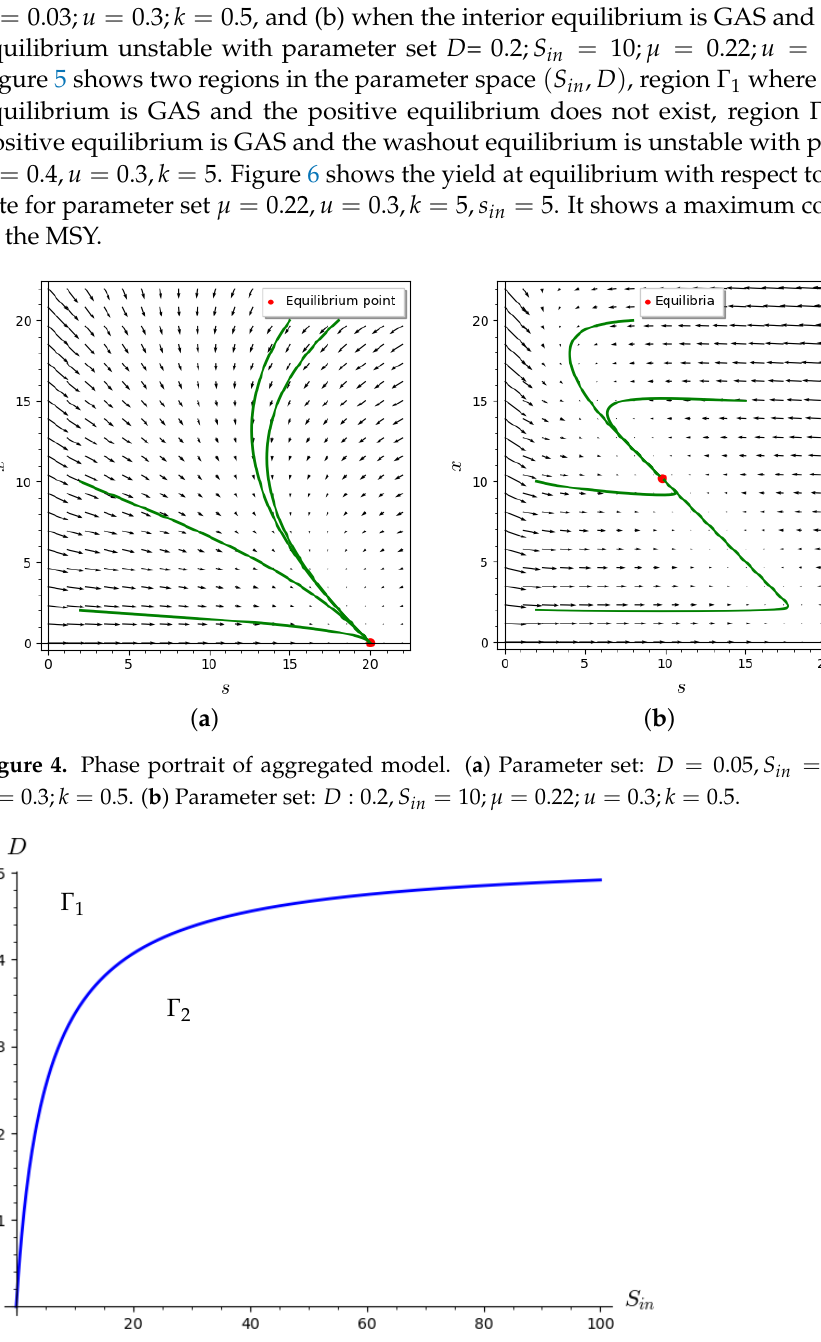
Figure 5. Parameter set: µ = 0.4, u = 0.3, k = 5, graph of function D = f ( S in ) . Region Γ 1 , where washout equilibrium is GAS and positive equilibrium does not exist. Region Γ 2 , where positive equilibrium is GAS and washout equilibrium is